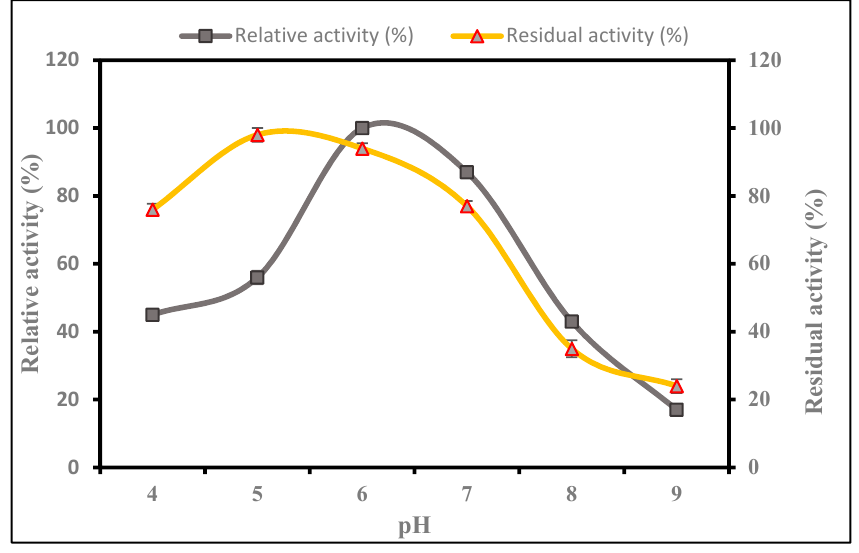
Figure 4. Effect of pH on protease activity and stability. Error bars represent standard deviation of three replicates.